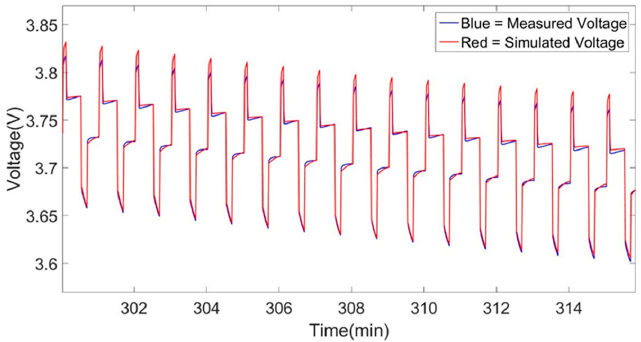
Figure 14. Error of the 1st Order Thévenin model measured and simulated DDP comparison at 25 °C with Coulomb counting and advanced characterization. Energies 2016 , 9 , 360